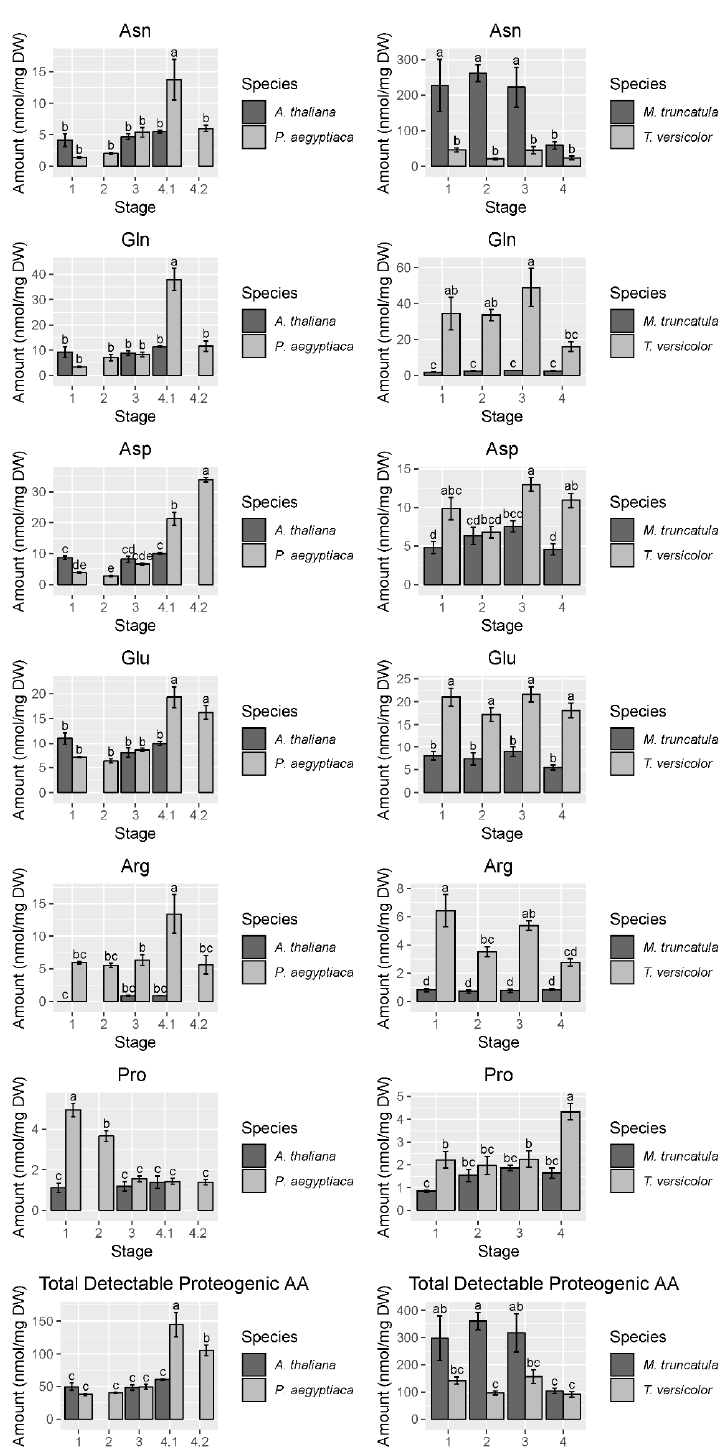
Figure 4. Abundance of selected free amino acids and total detectable protein-coding free amino acids. Data are taken from the first P. aegyptiaca experiment. Four to five biological replicates are used for each sample type. Note the di ff erence in scale between the P. aegyptiaca–A. thaliana and the T. versicolor–M. truncatula systems, particularly the high levels of asparagine in M. truncatula . In cases where A. thaliana host root was not collected for corresponding P. aegyptiaca stages, no data are shown. Tukey HSD connecting letters are given, run on host and parasite sample values concurrently. Standard error bars are